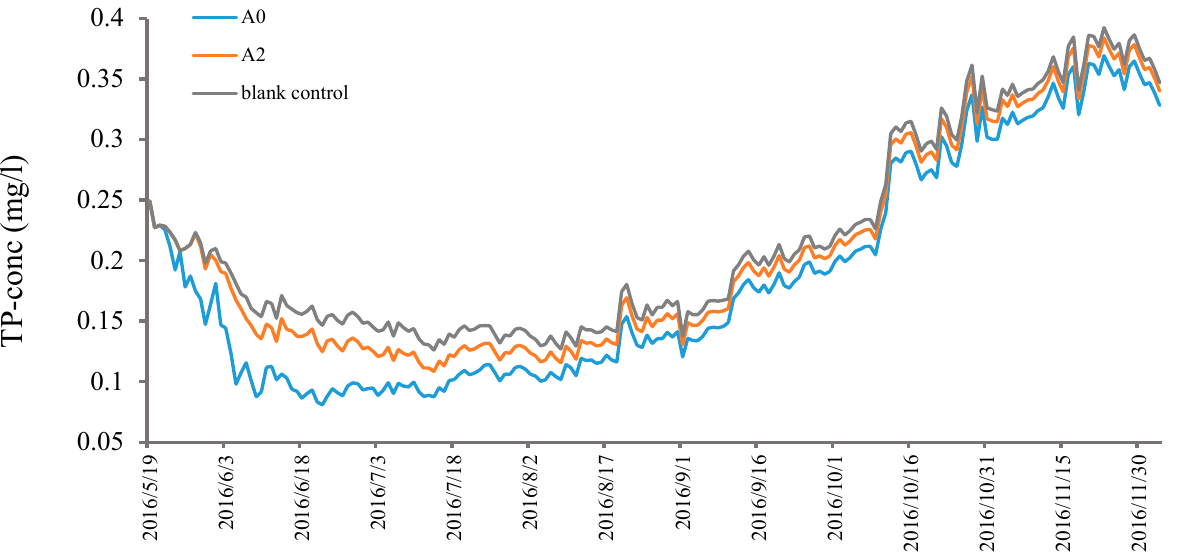
Figure 10. Time series graph of TP concentration for different sets of release positions (base1, T2, and 300 t/d).